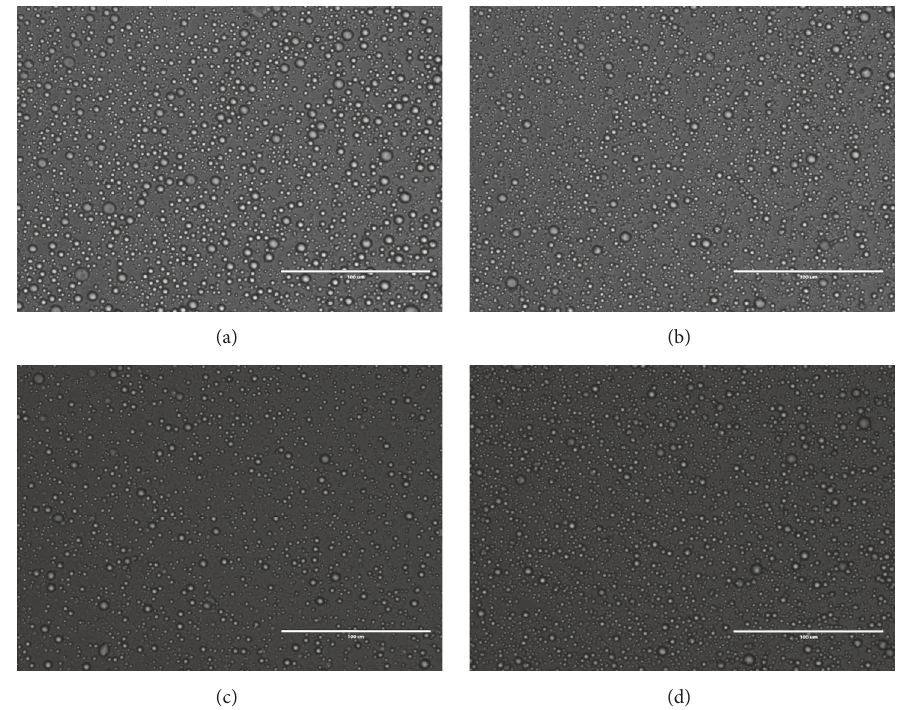
Figure 4: Light micrographs of washed oil body (WOBs) emulsions of pecan nuts soaked for 0 h (a and b) and 24 h (c and d). The scale bars represent 100 𝜇